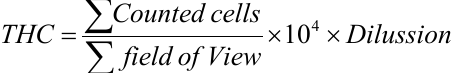
Table-1: Feed ingredients composition. Ingredients